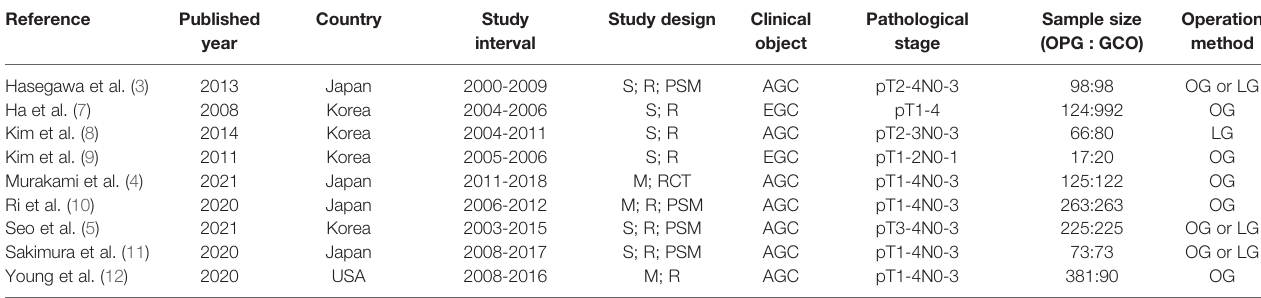
Study design Clinical Pathological Sample size Operation interval object stage (OPG : GCO)